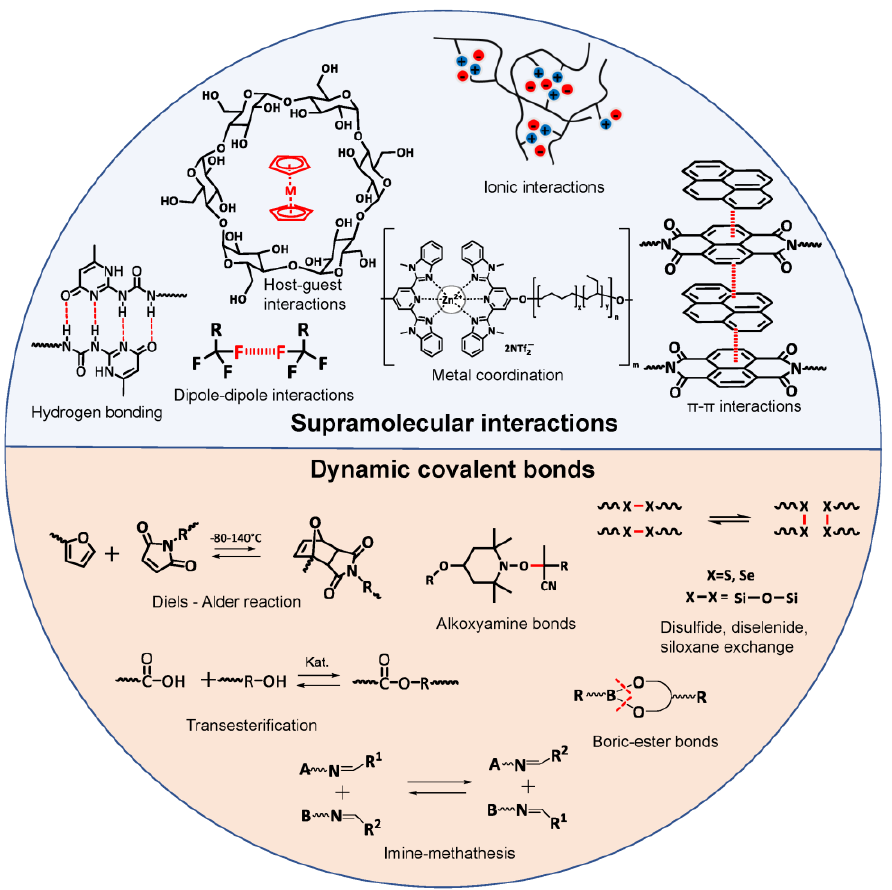
Figure 1. Chemical structures of the various supramolecular interactions and dynamic covalent bonds used for self-healing polymers.